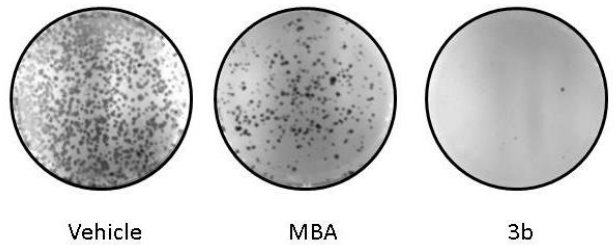
Figure 4. Silyl derivative 3b abolishes the clonogenic potential of HCT 116 cells; Representative colony formation images of the HCT cells after 24 h treatment with MBA and 3b are shown.